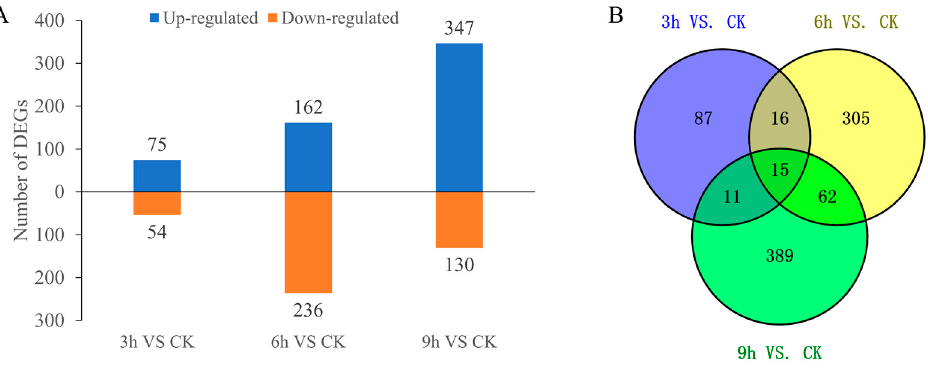
Figure 2. DEG statistics for centipedegrass under low-temperature stress compared with the CK. ( A ) Number of DEGs under different stress durations compared with the CK; ( B ) the DEGs at different time points compared with the CK are shown in a Venn diagram.